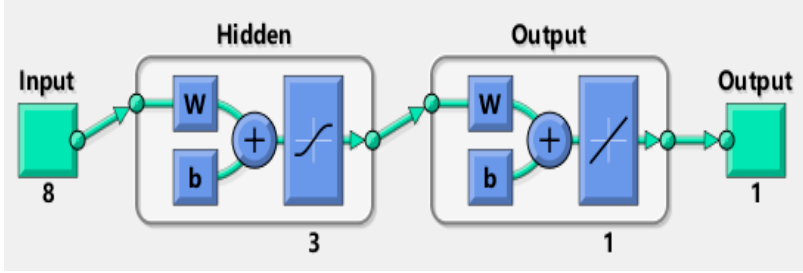
Figure 8. ANN structure for efficiency objective.